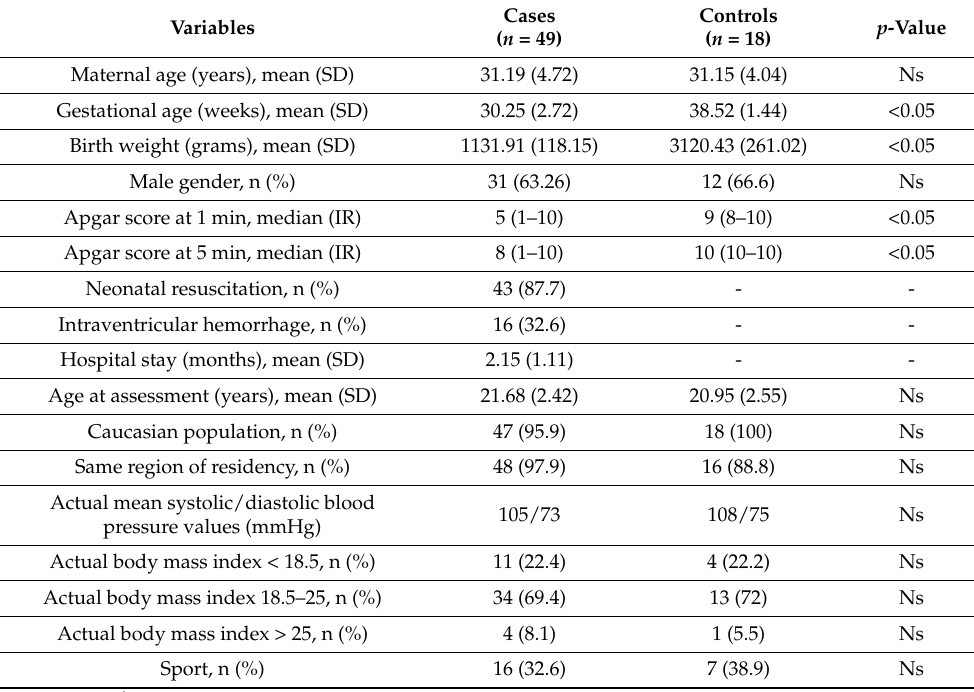
Table 1. Perinatal and actual data in case and control